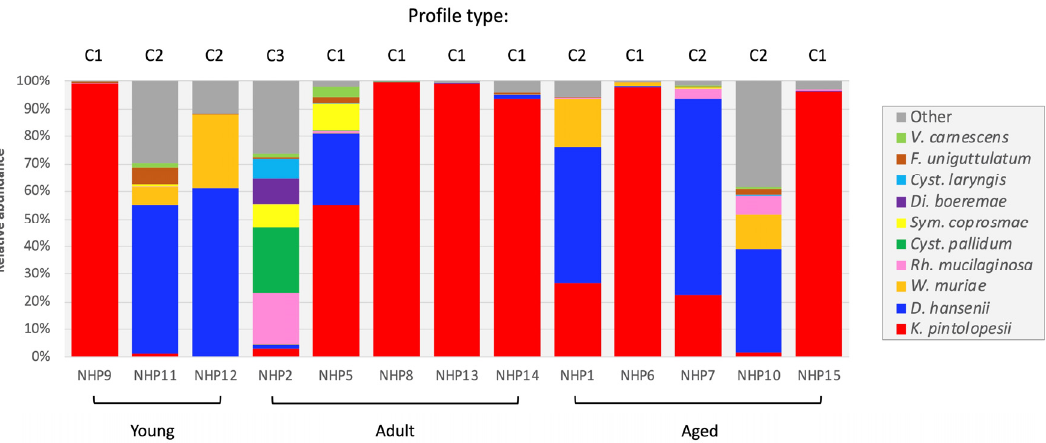
Figure 5. Comparison of the caecal mycobiome of 13 captive macaques of differing age (young, adult or aged).